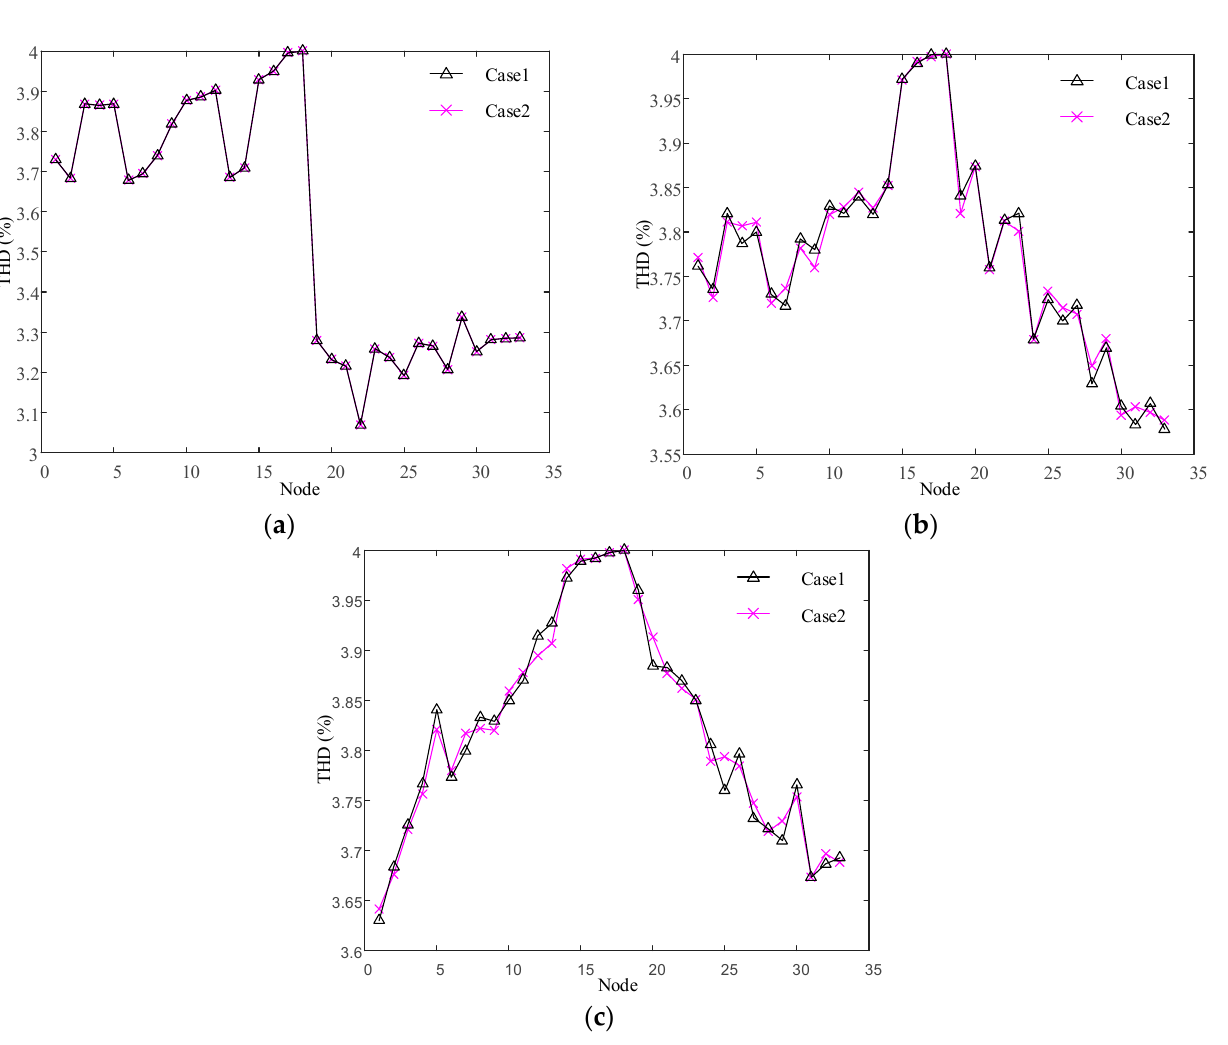
Table 12. Capacity comparison of each MFGCI participating in harmonic mitigation (kW).